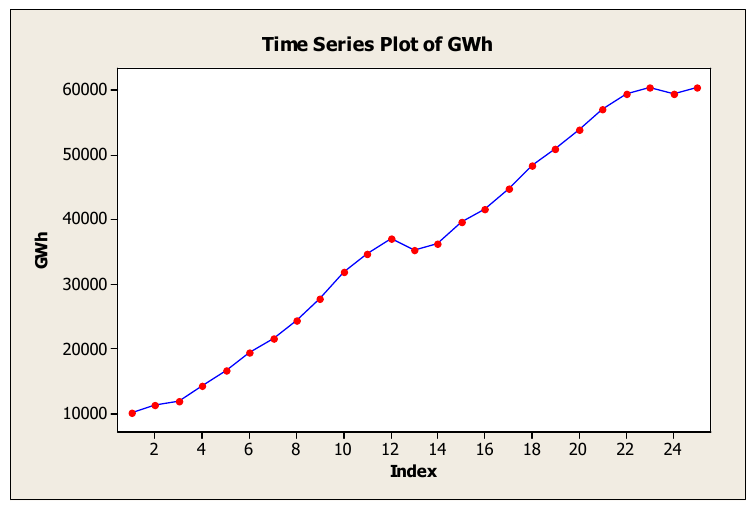
Figure 1. Time series plot of electricity demand.